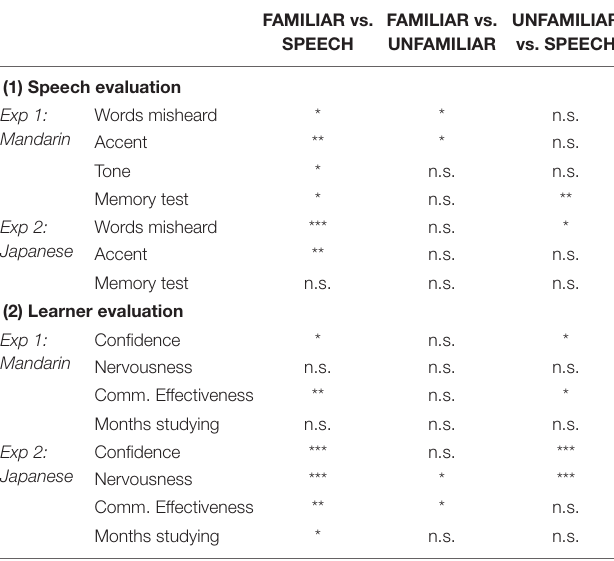
TABLE 3 | Summary of significant differences between conditions: FAMILIAR Gesture, UNFAMILIAR Gesture, and SPEECH Alone.